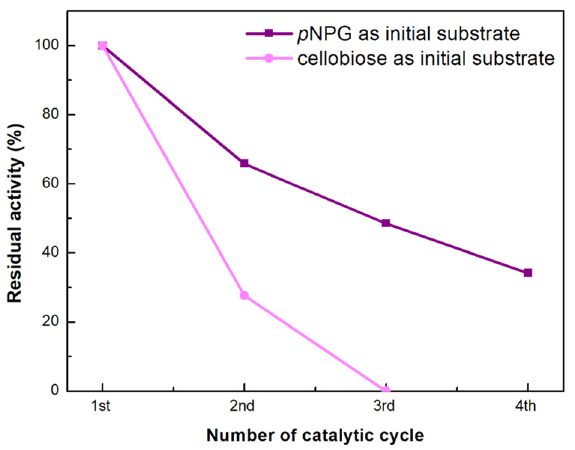
Figure 13. Reusability of the tri-enzymatic nanobiocatalytic system for the cascade reaction using as initial substrate p NPG and cellobiose, at 30 and 50 °C: residual activities during four consecutive cycles. The activity at the first catalytic cycle was set at 100% (error bars are too small to be visible).